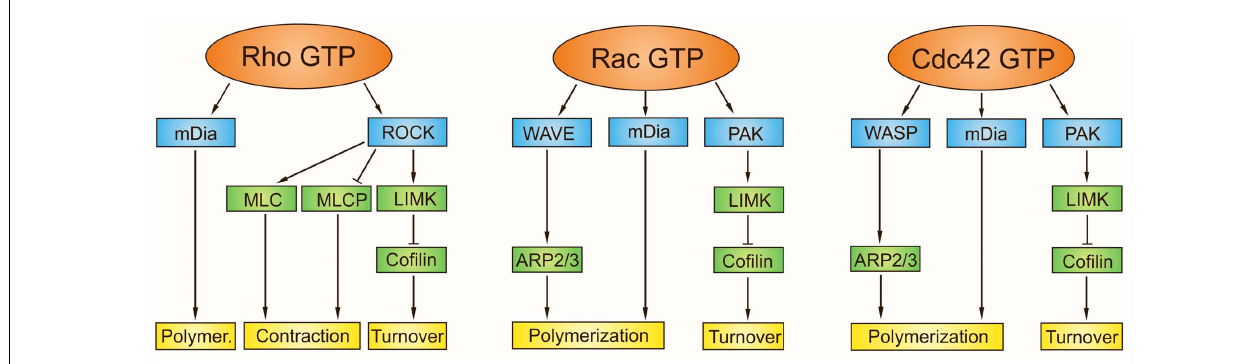
FIGURE 7 | Downstream effector targets of Rho family GTPases for generation of actin cytoskeletal structures. The downstream targets of active Rho GTPases, with bound GTP, include kinases (p21-activated kinase, PAK; Rho-associated coiled-coil kinase; ROCK) and nucleation promoting factors (mammalian Diaphanous formin, mDia;Wiskott-Aldrich syndrome protein,WASP;Wiskott-Aldrich syndrome protein-family verprolin homologous protein,WAVE).While nucleation by mDia produces unbranched actin filaments,WASP andWAVE interact with Arp2/3 complex and generate branched microfilaments. PAK phosphorylates LIM-motif containing kinase (LIMK), that in turn phosphorylates